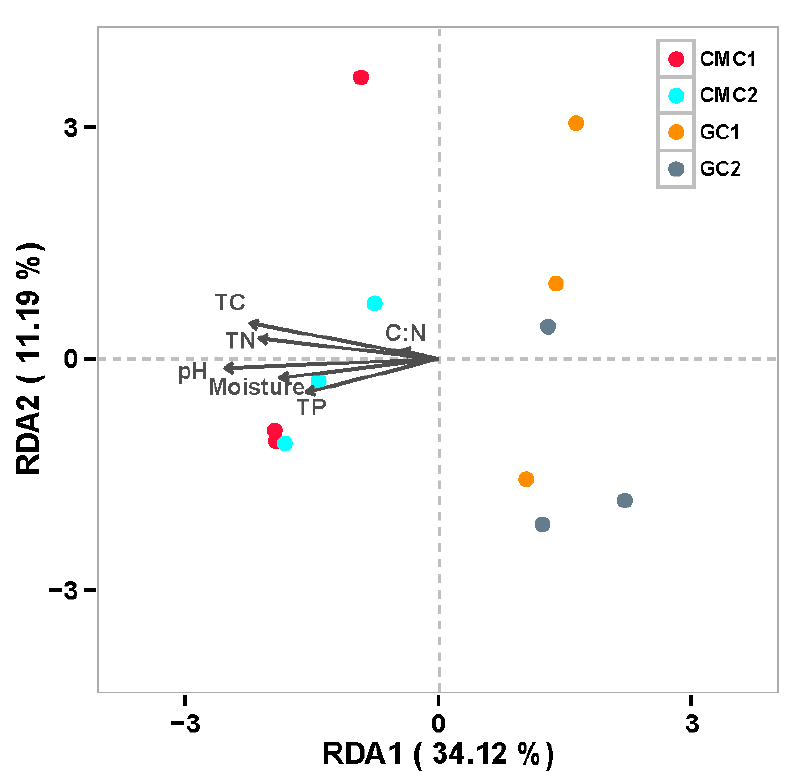
Figure 6. Redundancy analysis of environmental variables for the sediment bacterial communities at the phylum levels in aquaculture ponds. The explanatory variables are shown by different arrows. Filled circles represent sediment samples collected from aquaculture ponds. See Table 1 and Figure 1 for abbreviations.